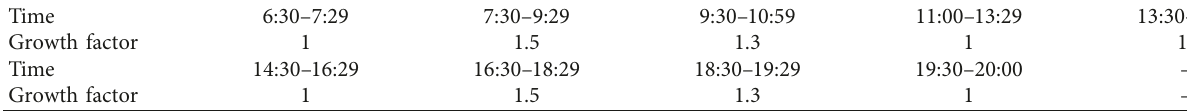
Table 4: The growth factor of travel time departure at different time periods.